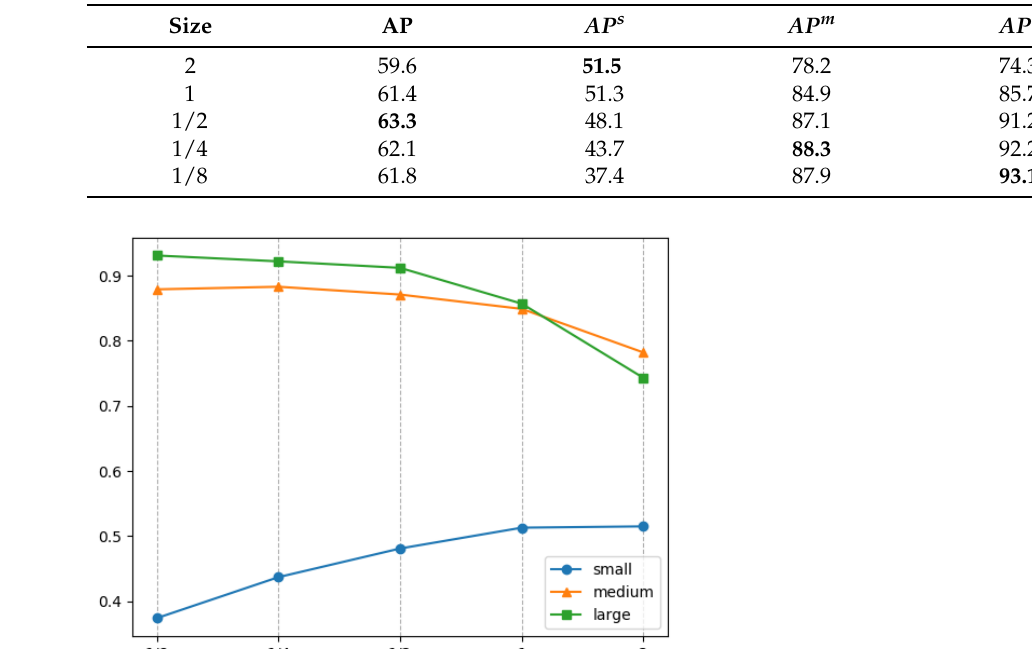
Table 1. The influence of convolution feature size change on ship detection accuracy.